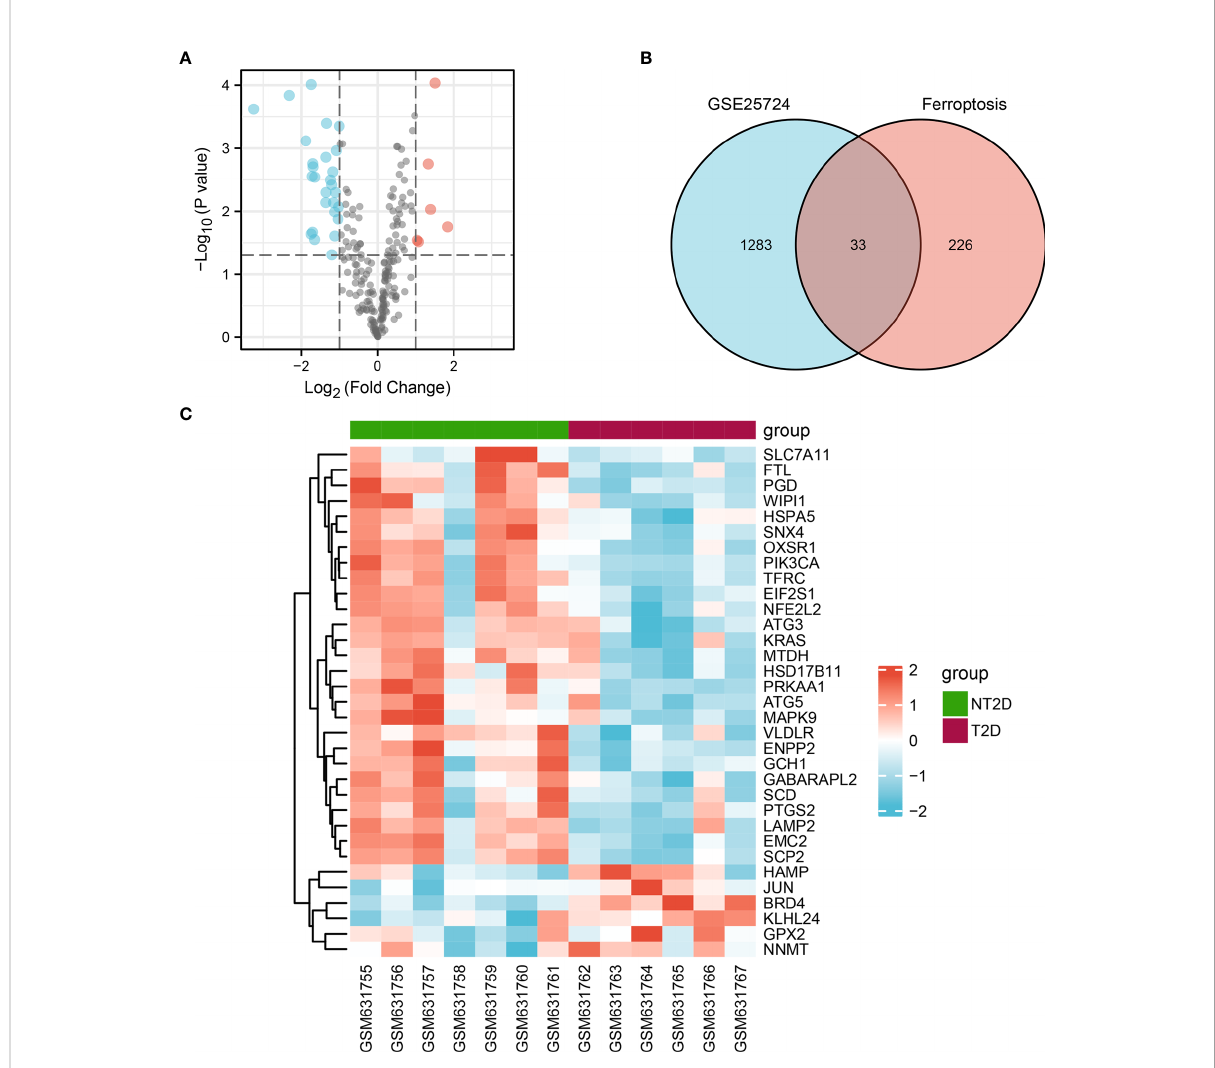
FIGURE 3 Ferroptosis-related DE-mRNAs between T2D islet and NT2D islet samples. (A) Volcano plot of 216 ferroptosis-related genes including six upregulated and 27 downregulated genes. Red, upregulation; green, downregulation. (B) Venn diagram to screen ferroptosis-related DE- mRNAs. (C) The heat map of 33 ferroptosis-related DE-mRNAs between T2D islet and NT2D islet